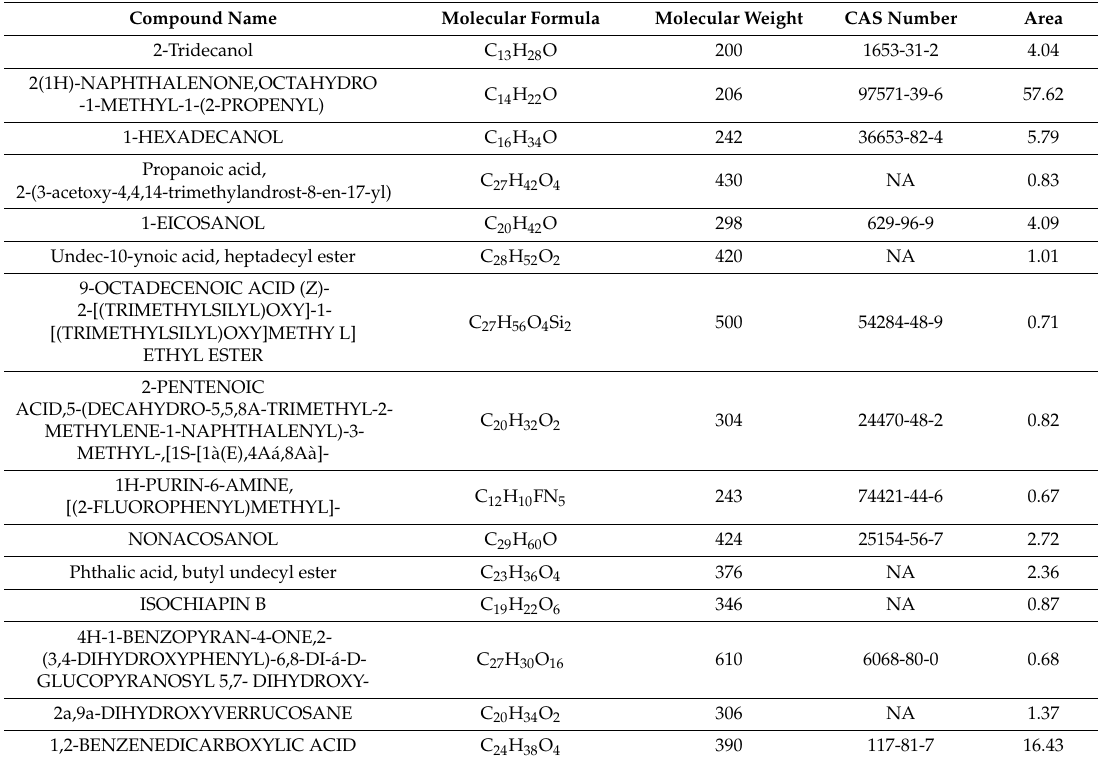
Table 2. GC chromatographic analyses of ethyl acetate extract of mushroom culture filtrate (MCF) of P.